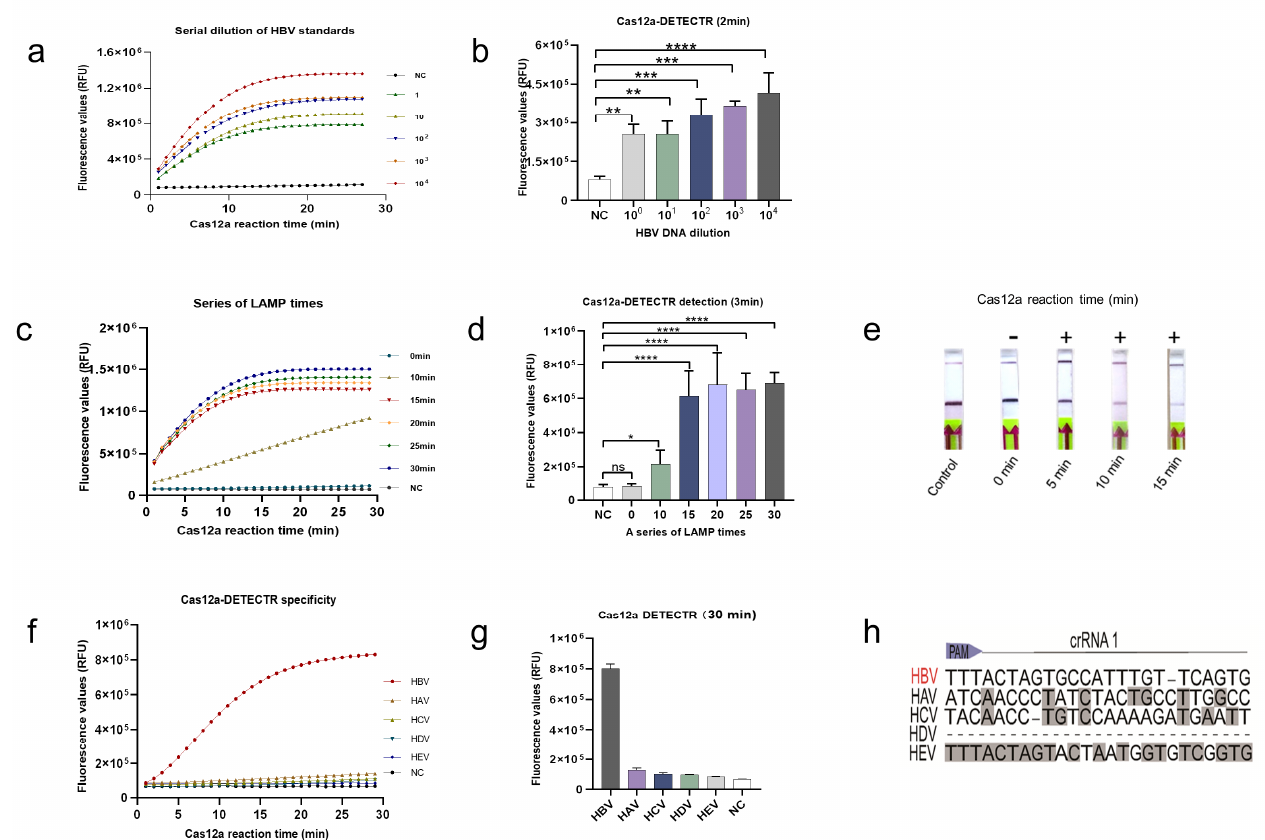
Figure 3. Determination of LoD and specificity of Cas12a-DETECTR assay. ( a ) Fluorescence curves generated by the Cas12a-DETECTR reaction at each dilution. Data were expressed as mean ± SD. from triplicate assays. Negative control (NC) utilized RNase-free water as input instead of HBV DNA dilutions. ( b ) Comparison of fluorescence values generated after 2 min of Cas12a-DETECTR reaction at each dilution. ( c ) Fluorescence curves generated by the Cas12a-DETECTR reaction at each LAMP incubation time gradient (HBV concentration is 1 copy/ µ L). ( d ) Comparison of fluorescence values generated after 3 min of Cas12a-DETECTR reaction at each LAMP incubation time gradient (HBV concentration, 1 copy/ µ L). ( e ) Comparison of lateral flow test strip results at each Cas12a-DETECTR reaction time gradient after 15 min of LAMP incubation (HBV concentration is 1 copy/ µ L). ( f ) HBV Cas12a-DETECTR fluorescence readout assays for different hepatitis virus clinical samples. ( g ) The fluorescence values generated after 30 min of Cas12a-DETECTR reaction for each virus. ( h ) The sequence alignment of nucleotides in the crRNA 1 target region of the HBV gene with other common human hepatitis viruses, including HAV, HCV, HDV, and HEV. +: indicates a positive sample, -: indicates a negative sample. **: p < 0.01; ***: p < 0.001; ****: p < 0.0001.